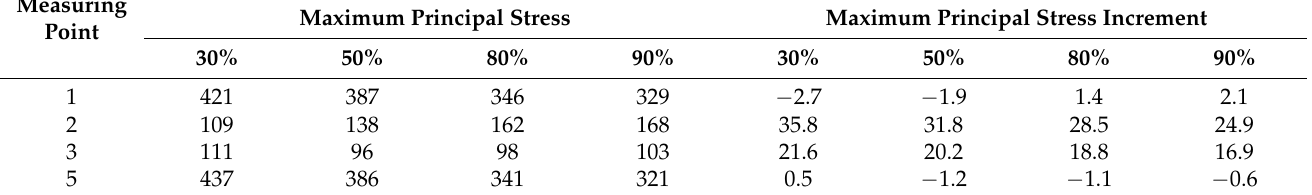
Table 13. Maximum principal stress amplitude of measuring points 1, 2, 3, and 5 under different softening degrees of basement surrounding rock.